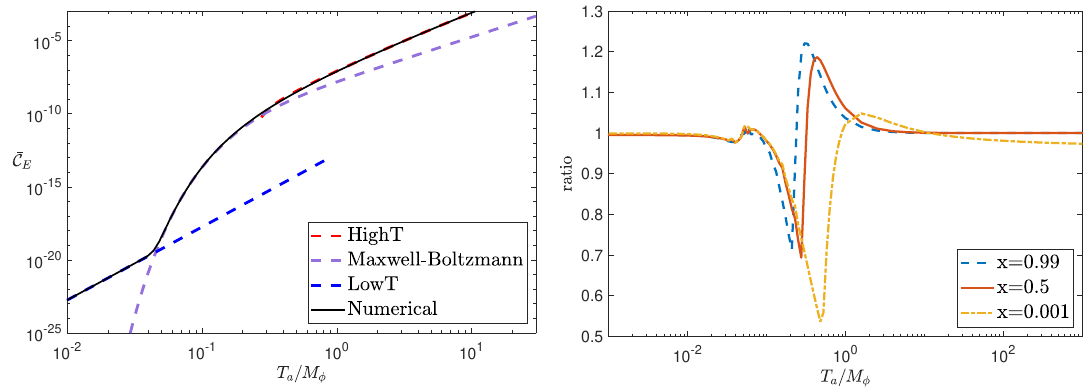
as a function of T a =M (cid:30) (cid:30)